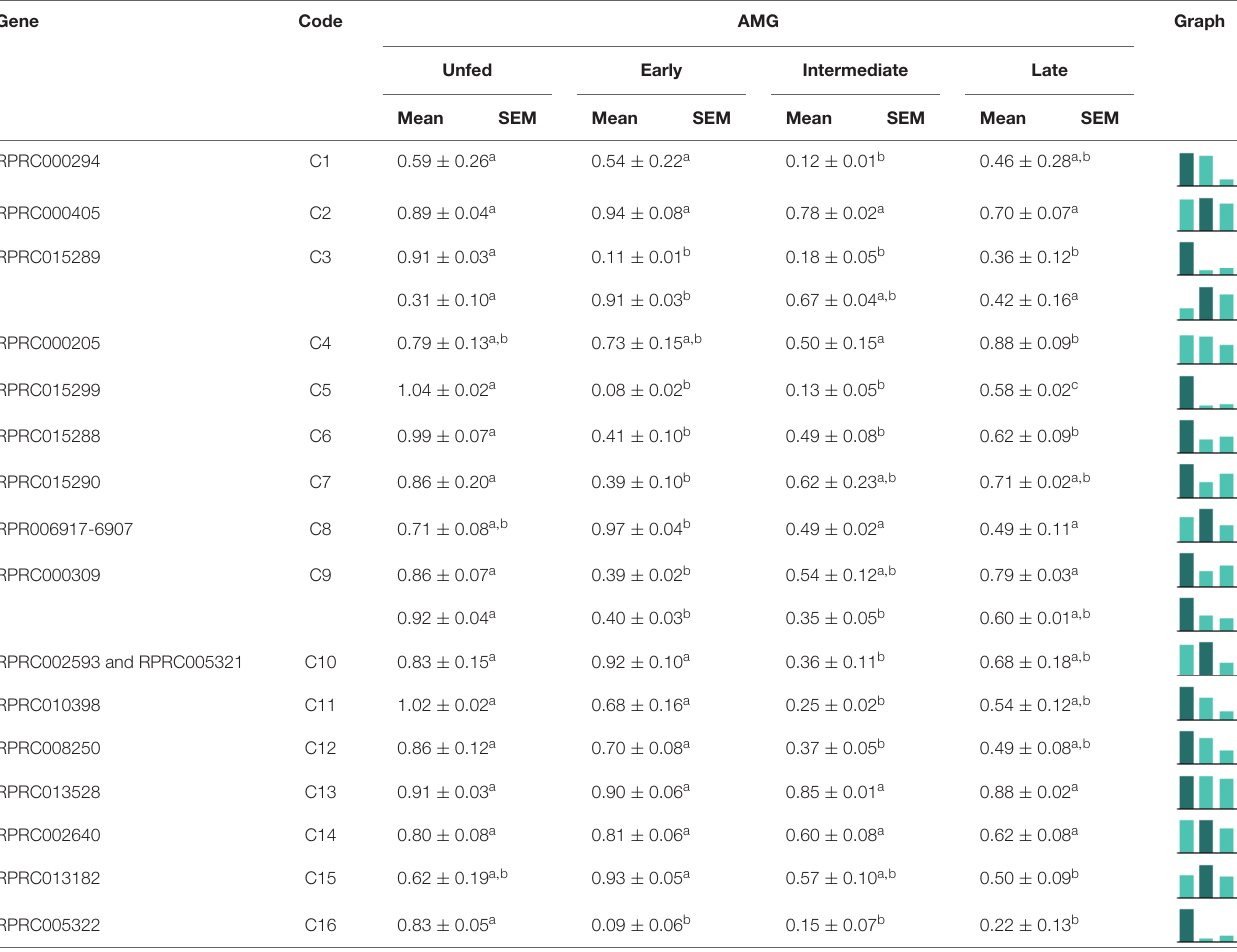
Figures are means ± SEM from three amplification determinations using cDNA pool preparations of six insect samples each. In a dataset, groups with the same superscript letter are not significantly different (p ≥ 0.05). In the miniature graphs, differently colored bars highlight the highest expression levels. Statistical analysis consisted of ordinary two-way ANOVA with Tukey’s multiple-comparisons